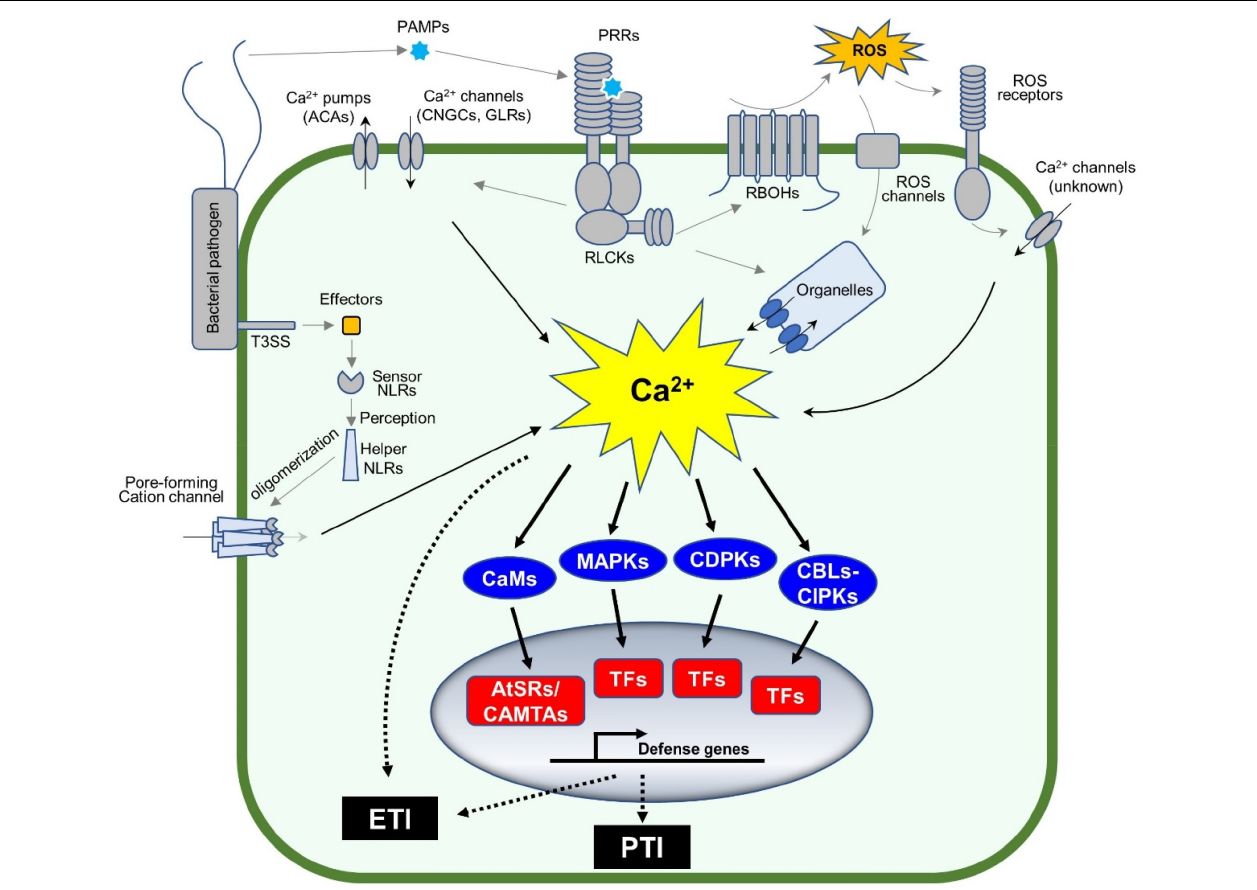
FIGURE 1 | Calcium signaling cascades control plant defense gene expression. Plants sense pathogens (e.g., bacteria in the figure) through pattern recognition receptors (PRRs) by recognizing the pathogen-associated molecular patterns (PAMPs). The activated PRRs phosphorylate themselves and other proteins including receptor-like cytoplasmic kinases (RLCKs). The phosphorylated RLCKs activate Ca 2 + channels or Ca 2 + pumps, leading to the dynamic changes in cytosolic Ca 2 + concentration, while the activated RLCKs phosphorylate RBOHs to produce apoplastic ROS accumulation, which indirectly induces the Ca 2 + influx in the plant cell. Ca 2 + sensors, such as CaM/CML, CBLs, and CDPKs, together with MAPKs, decode the pattern-triggered Ca 2 + spiking into downstream signaling. CBL-activated CIPKs and CDPKs phosphorylate a variety of transcription factors (TFs), such as WRKYs, to induce the expression of defense-related genes. In addition, the TFs (e.g., AtSRs/CAMTAs) activated by Ca 2 + -bound CaMs are involved in Ca 2 + -mediated immune response. The entire process is important to activate pattern-triggered immunity (PTI). On the other hand, pathogens secrete proteins, so-called effectors, into the plant cell to repress the plant immune system, also known as ETS. However, the effectors are recognized by intracellular nucleotide-binding domain and leucine-rich repeat proteins (NLRs) to activate a strong and rapid immune response, known as effector-triggered immunity (ETI). The activated NLRs oligomerize and form a non-canonical Ca 2 + -permeable channel in the